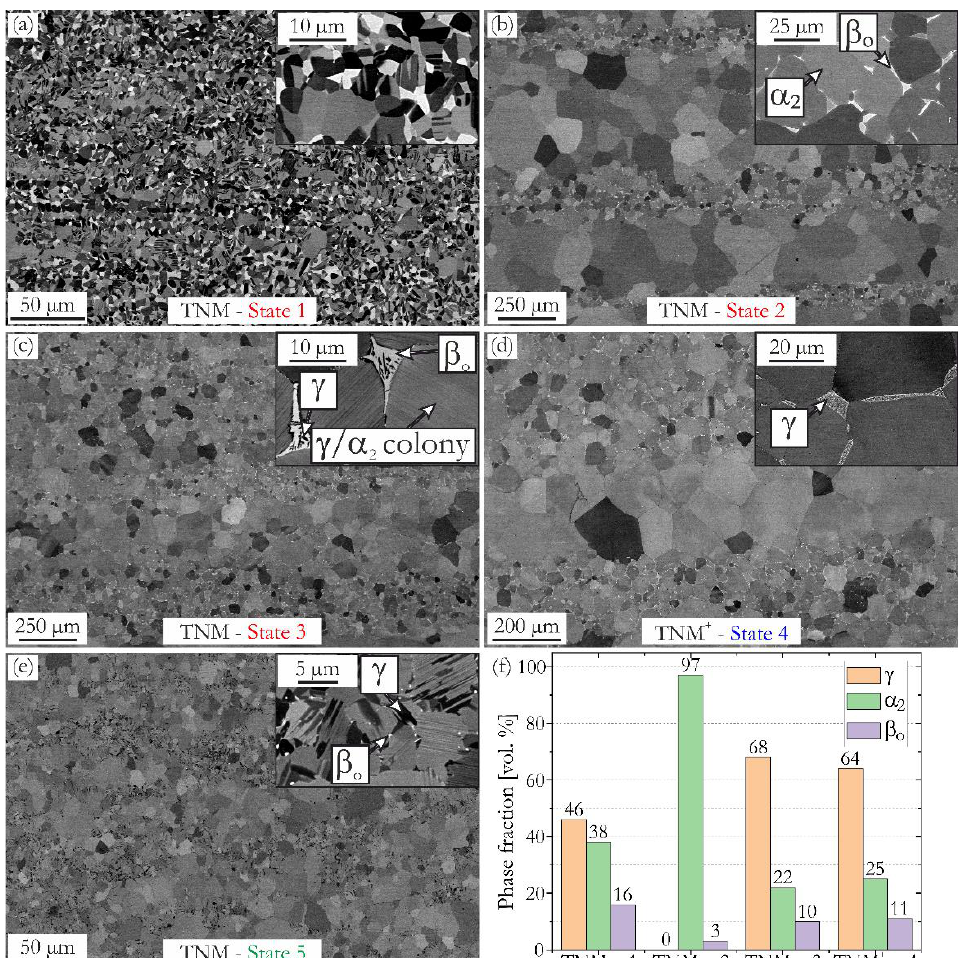
Figure 5. Evolution of the microstructure of the TNM alloy during heat treatment procedure 1 (see Figure 2), ( a – c ) represent states 1 – 3 as indicated in Figure 2a; ( d ) microstructure of the TNM + alloy after procedure 2 (state 4); ( e ) microstructure of the TNM alloy after procedure 3 (state 5). The insets depict details of the microstructure (see text). All SEM images were taken in BSE mode; ( f ) phase fractions determined by means of XRD for the shown microstructures.